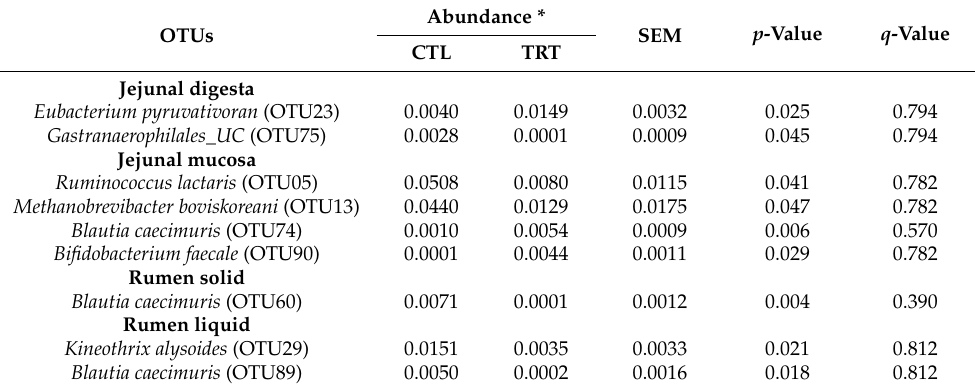
Table 5. Operational taxonomic units (OTU) within the 100 most abundant showing differences ( p ≤ 0.05) between control (CTL) and MCE-fed (TRT)